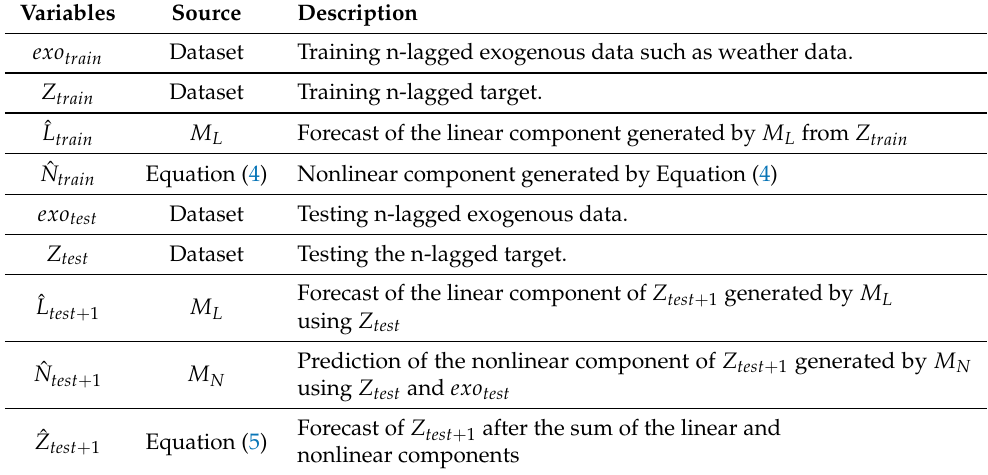
Table 1. List of variables of the proposed hybrid